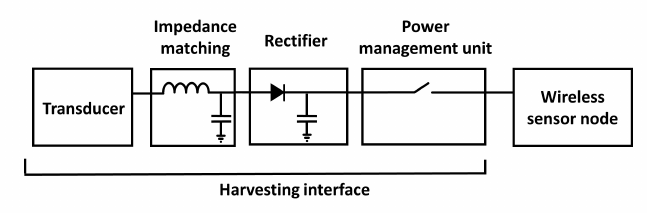
Figure 1. General architecture of a wireless sensor node (WSN) powered by an energy harvester interface.